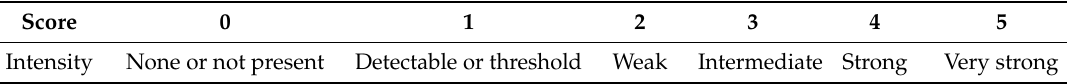
Table 1. Sensory quantitative description of Xiaoqu